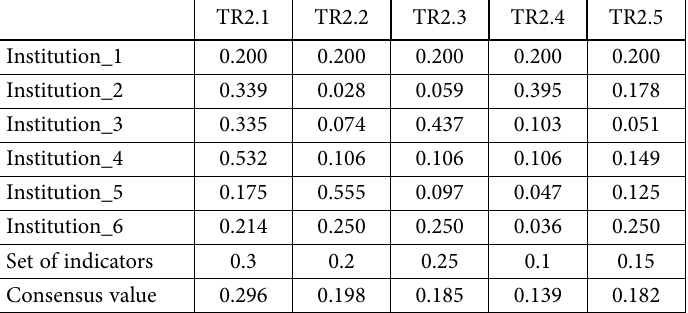
Table 4. Transparency-indicator weighting. Mission, vision and values